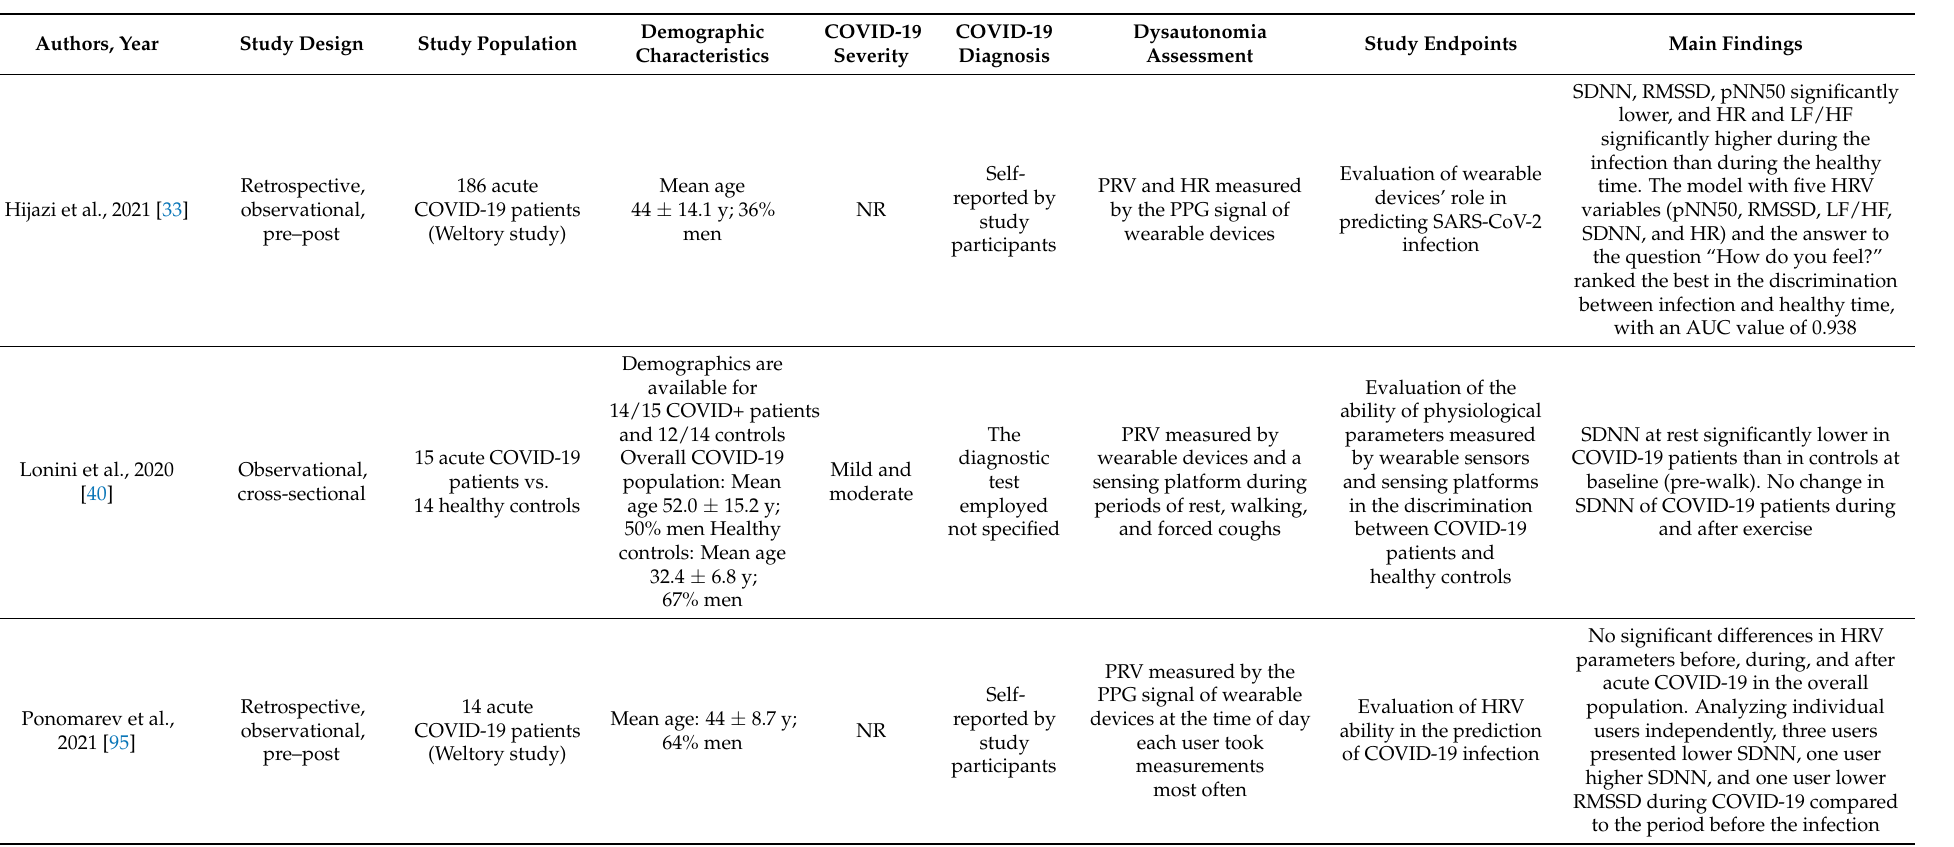
Table 4. A graphic representation of the data extracted from the three studies analyzing the autonomic parameters’ role in predicting the SARS-CoV-2